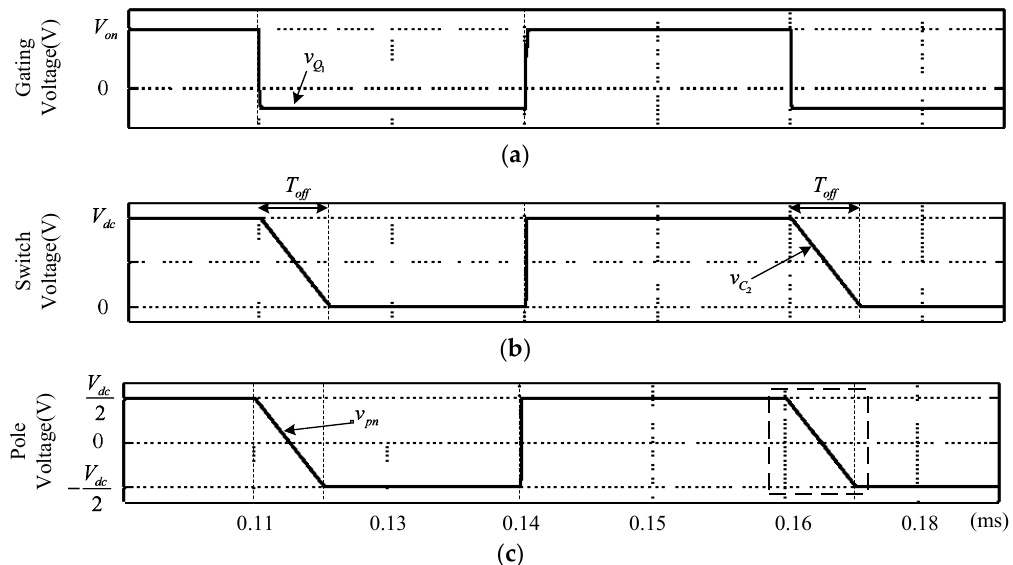
v ; ( b ) lower output capacitor voltage ; ( b ) lower output capacitor voltage v C 1 1 Q